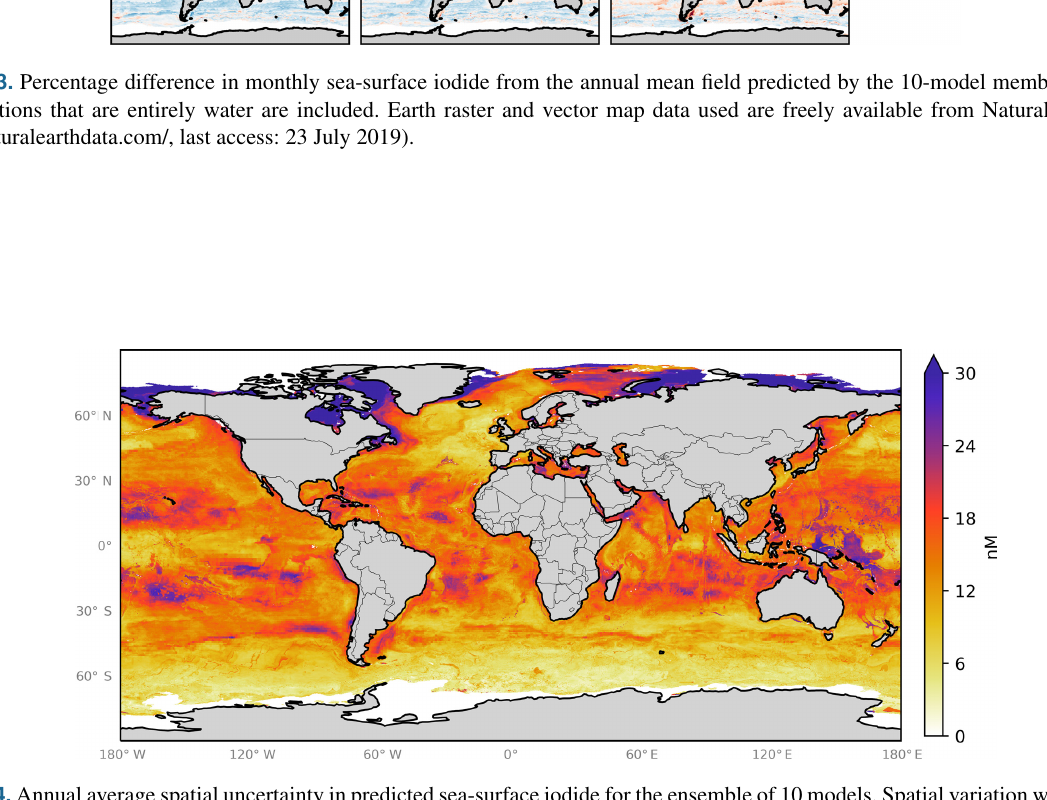
Earth Syst. Sci. Data, 11, 1239–1262, 2019